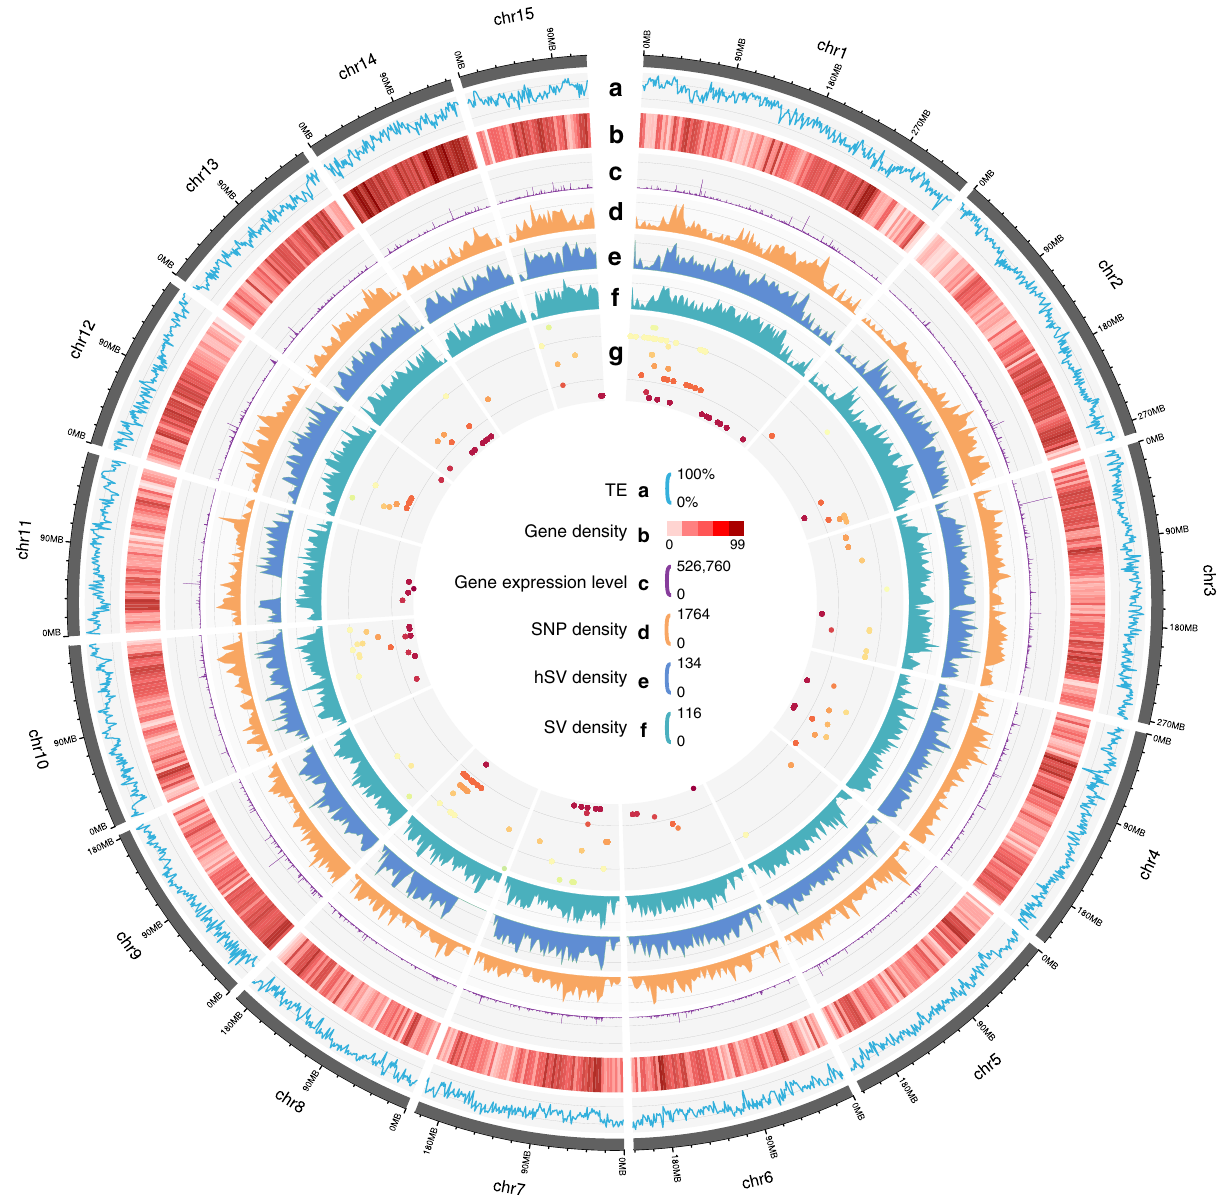
Fig. 1 Features of DASZ genome and mQTL distributions. a Transposable-element content in each chromosome calculated using nonoverlapping window size of 1 Mb. b Gene density (numbers of genes in 1 Mb nonoverlapping windows). c Gene expression levels (sum of gene expression levels of each gene